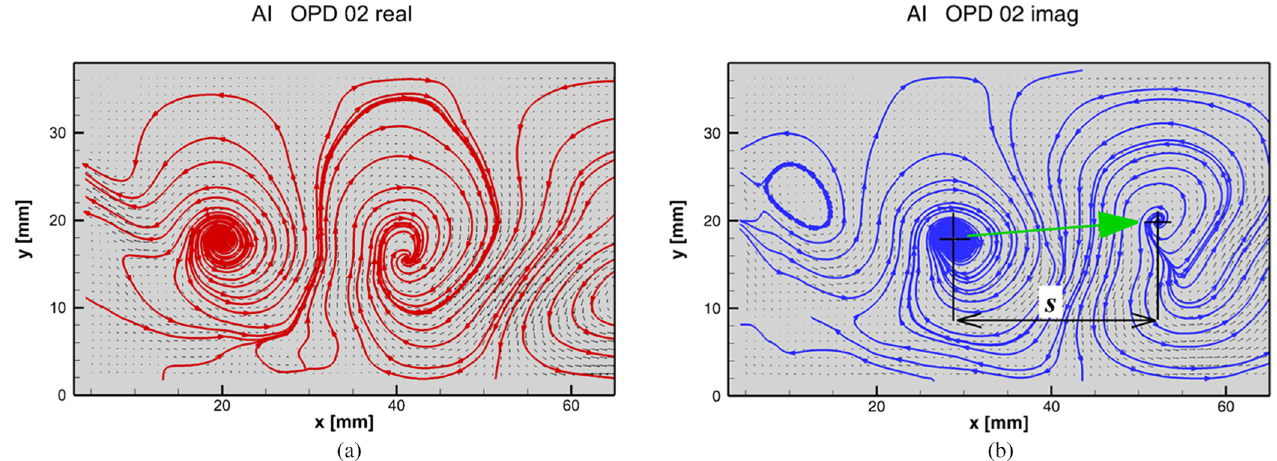
Fig. 12. Topology of the OPD mode no. 2 in the branch A, zone I, real (a) and imaginary (b)